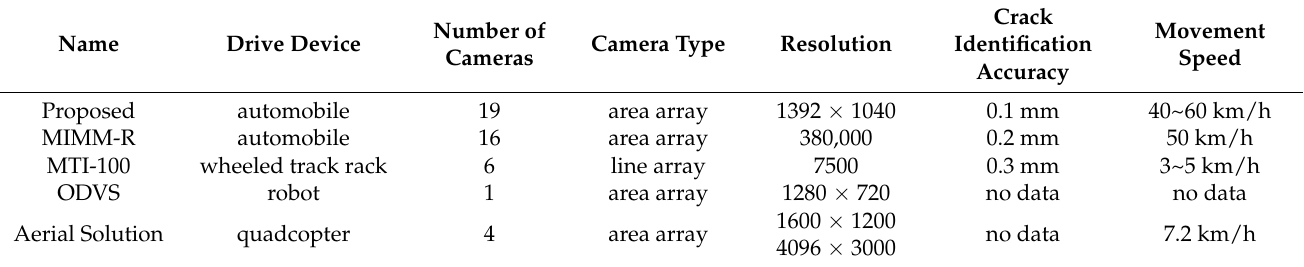
Table 5. Comparison table with other recent